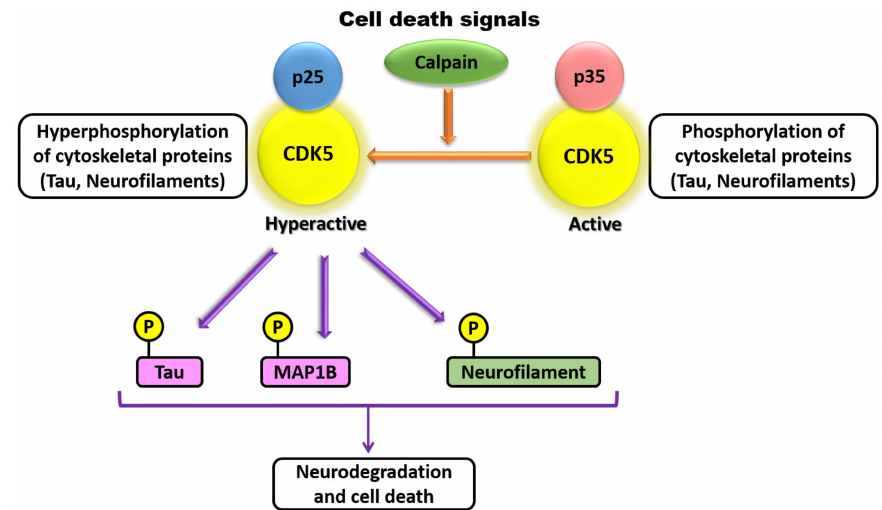
Figure 3. Cyclin-dependent kinase-5 (Cdk5) substrates in brains with neurodegenerative diseases. In a neurodegenerative brain disease, there is Caplain cleavage in the N-terminal region of p35 to a more stable isoform p25, forming a CDK5 / p25. This stable complex strongly phosphorylates neurofilaments, Tau, and another microtubule-associated protein, MAP1B compared with CDK5 / p35